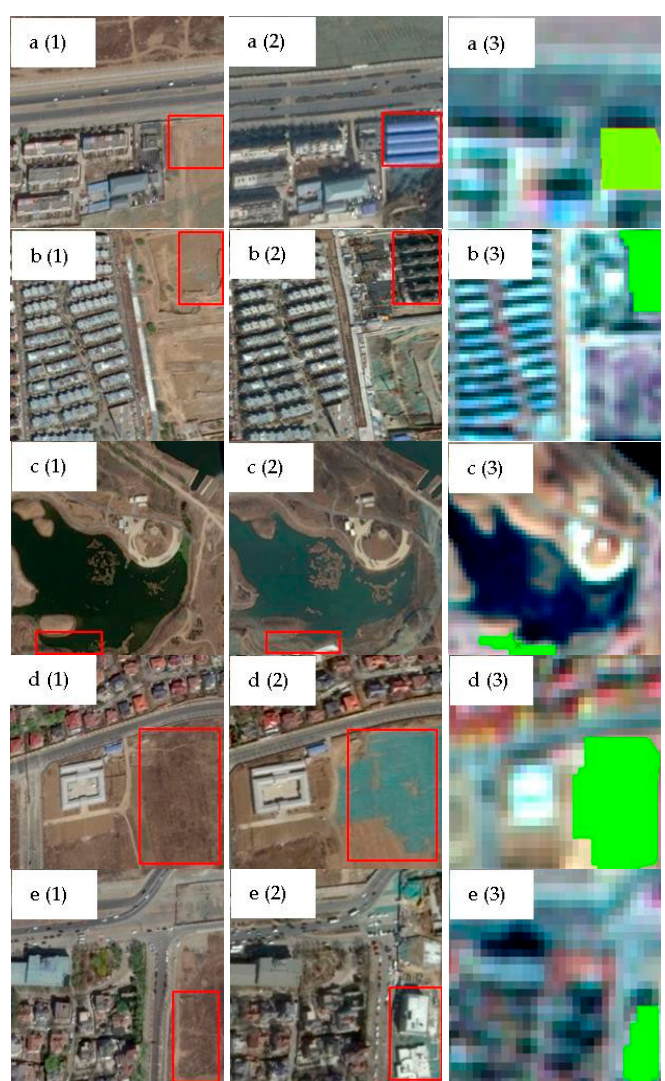
Figure 17. ODCD land cover change detection result overlaid on the GF-1 image of Beijing in February 2017.